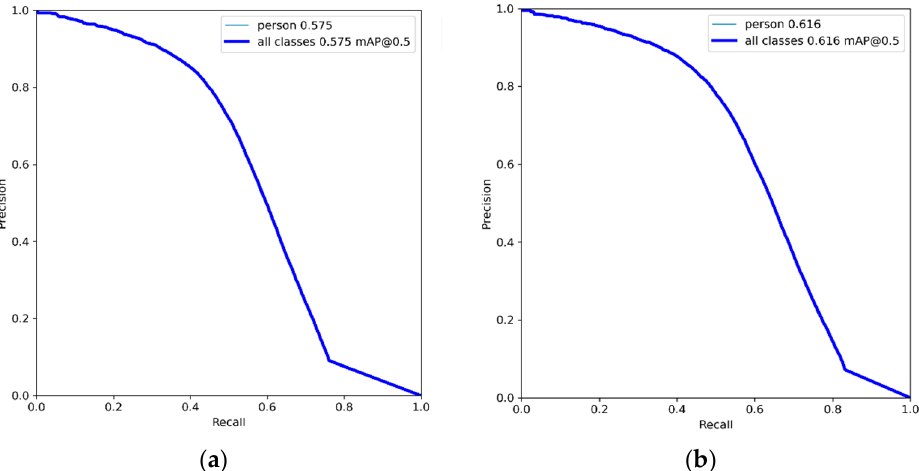
Figure 7. YOLOv5 ( a ) vs. YOLOv5s-improved ( b ) method Precision–Recall curves on the validation set.